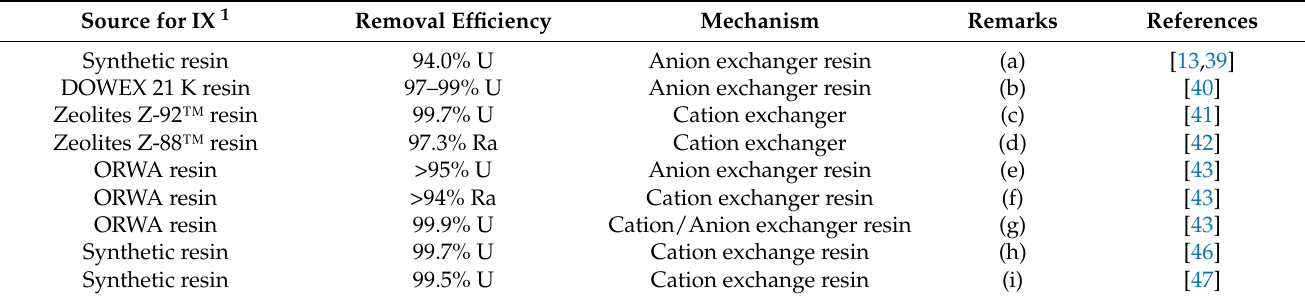
Table 1. Summary of the ion exchange (IX) performance for uranium and radium